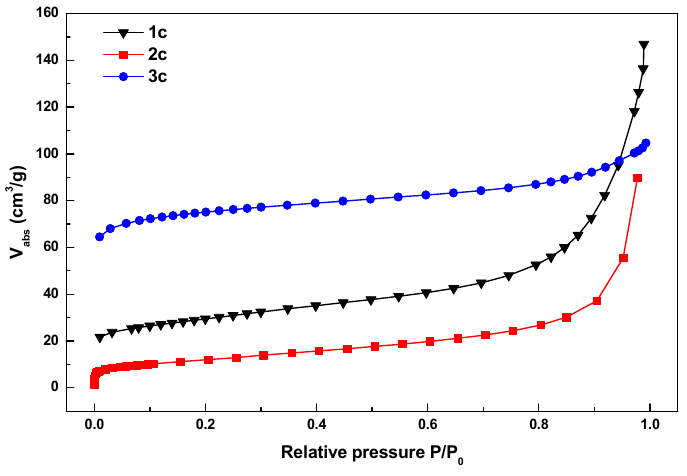
Figure 9. The N gas adsorption isotherms for 1c – 3c at 77 2 Figure 9. The N 2 gas adsorption isotherms for 1c – 3c at 77 K. Figure 9. The N 2 gas adsorption isotherms for 1c – 3c at 77 K.